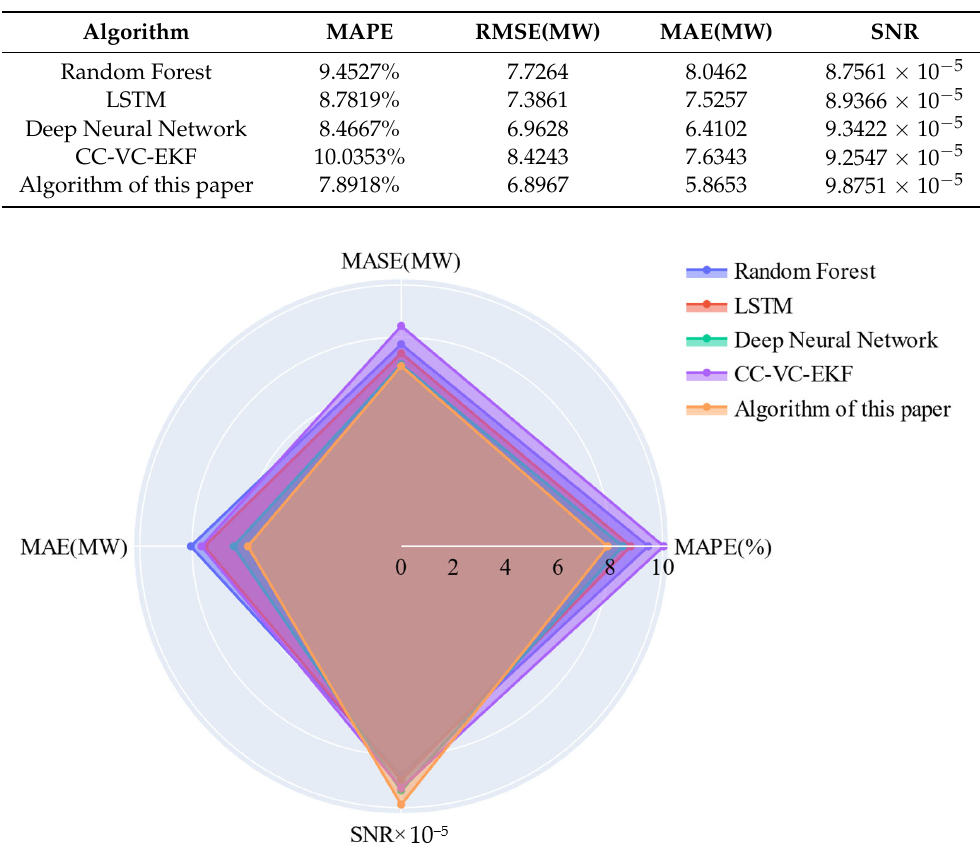
Table 1. Comparison of filtering results of different algorithms.